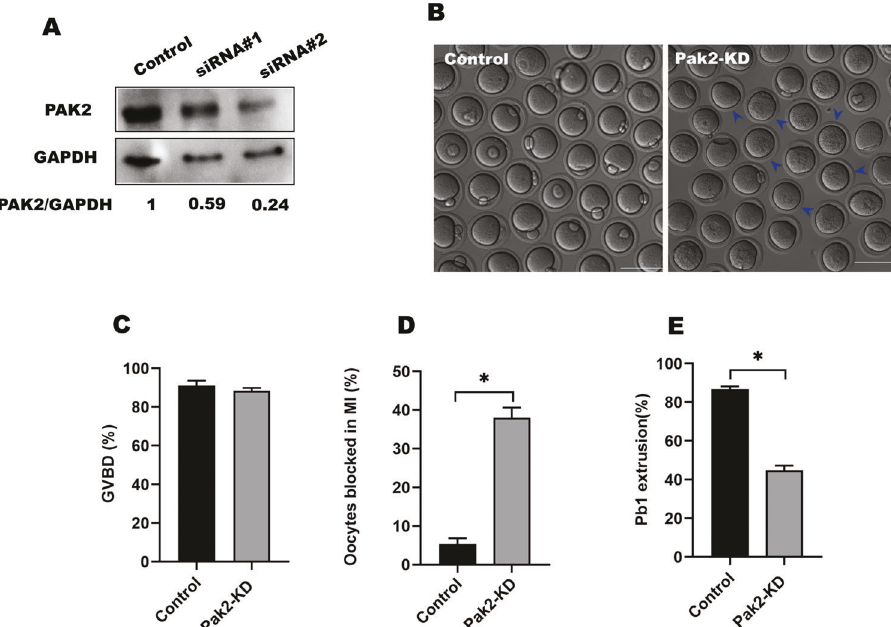
Fig. 2 Pak2 -knockdown (KD) adversely affects meiotic progression in oocytes. A KD of endogenous PAK2 protein after Pak2 -siRNA injection was con fi rmed by western blot analysis. B Representative images of oocytes from control and Pak2 -KD groups. Blue arrowheads indicate oocytes that were arrested at metaphase I and failed to extrude polar bodies (scale bar, 80 µm). C Quantitative analysis of GVBD rate between control ( n = 120) and Pak2 -KD ( n = 108) oocytes (91.0 ± 2.16%, n = 120; 88.3 ± 1.25, n = 108, respectively). D Percentage of meiosis I-arrested oocytes after Pak2 -siRNA injection (5.3 ± 1.25%, n = 120, control; 38.0 ± 2.16%, n = 108, Pak2 -KD). E Quantitative analysis of Pb1 extrusion rate between control and Pak2 -KD oocytes (86.7 ± 1.25%, n = 120; 44.7 ± 2.05%, n = 108, respectively). The graph shows the mean percentage ± SD of the results obtained from three independent experiments. *Signi fi cantly different ( p <